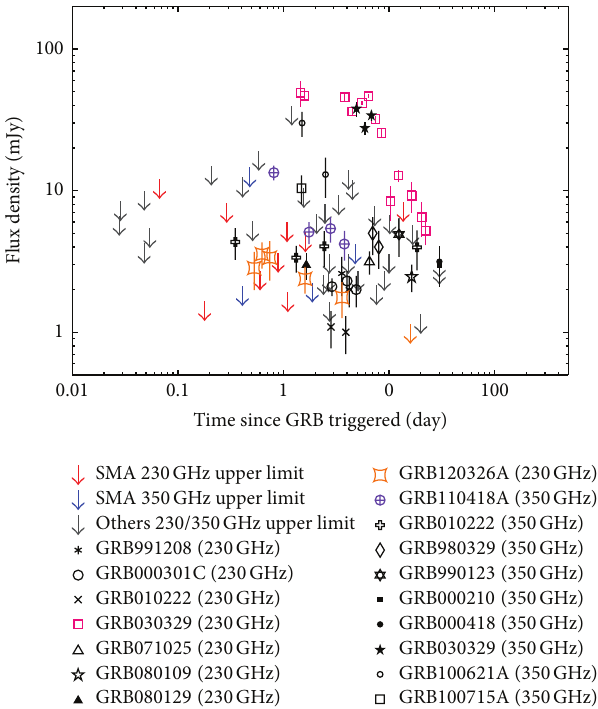
Figure 2: Light curve summary of afterglow observations in submm bands (230 and 345 GHz). Red (230 GHz upper limits), blue (345 GHz upper limits), orange (GRB120326A), and purple (GRB100418A) points were obtained with the SMA. The SMA suc- cessfully monitored two of three well-observed submm afterglows, GRB100418A and